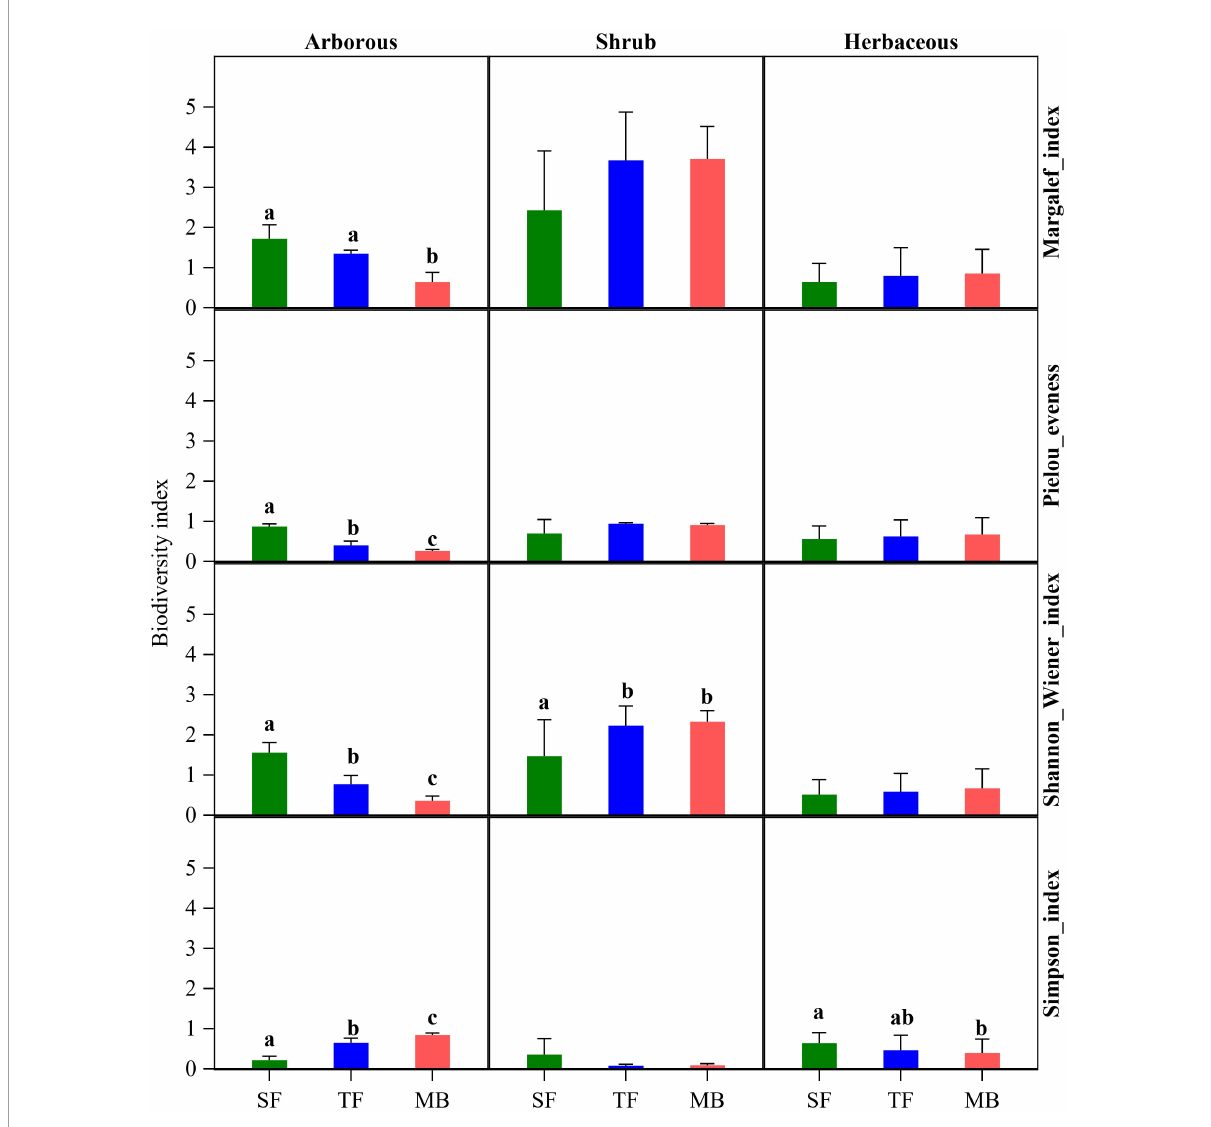
FIGURE2 Effect of the Moso bamboo invasion on species diversity of each layer. Different letters in the same column indicate significant differences at P < 0.05.